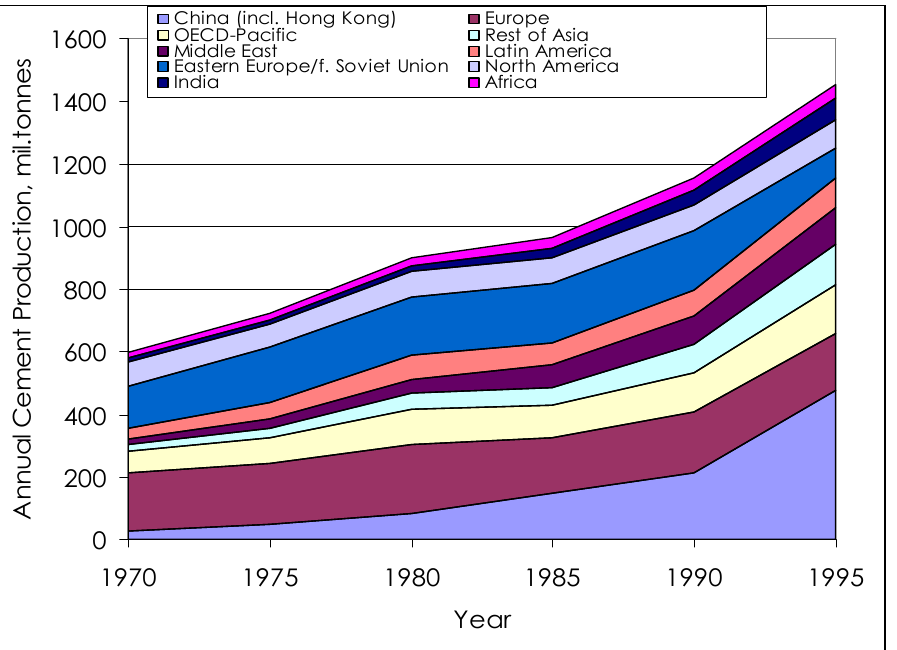
FIGURE 1 . Production trends in the cement